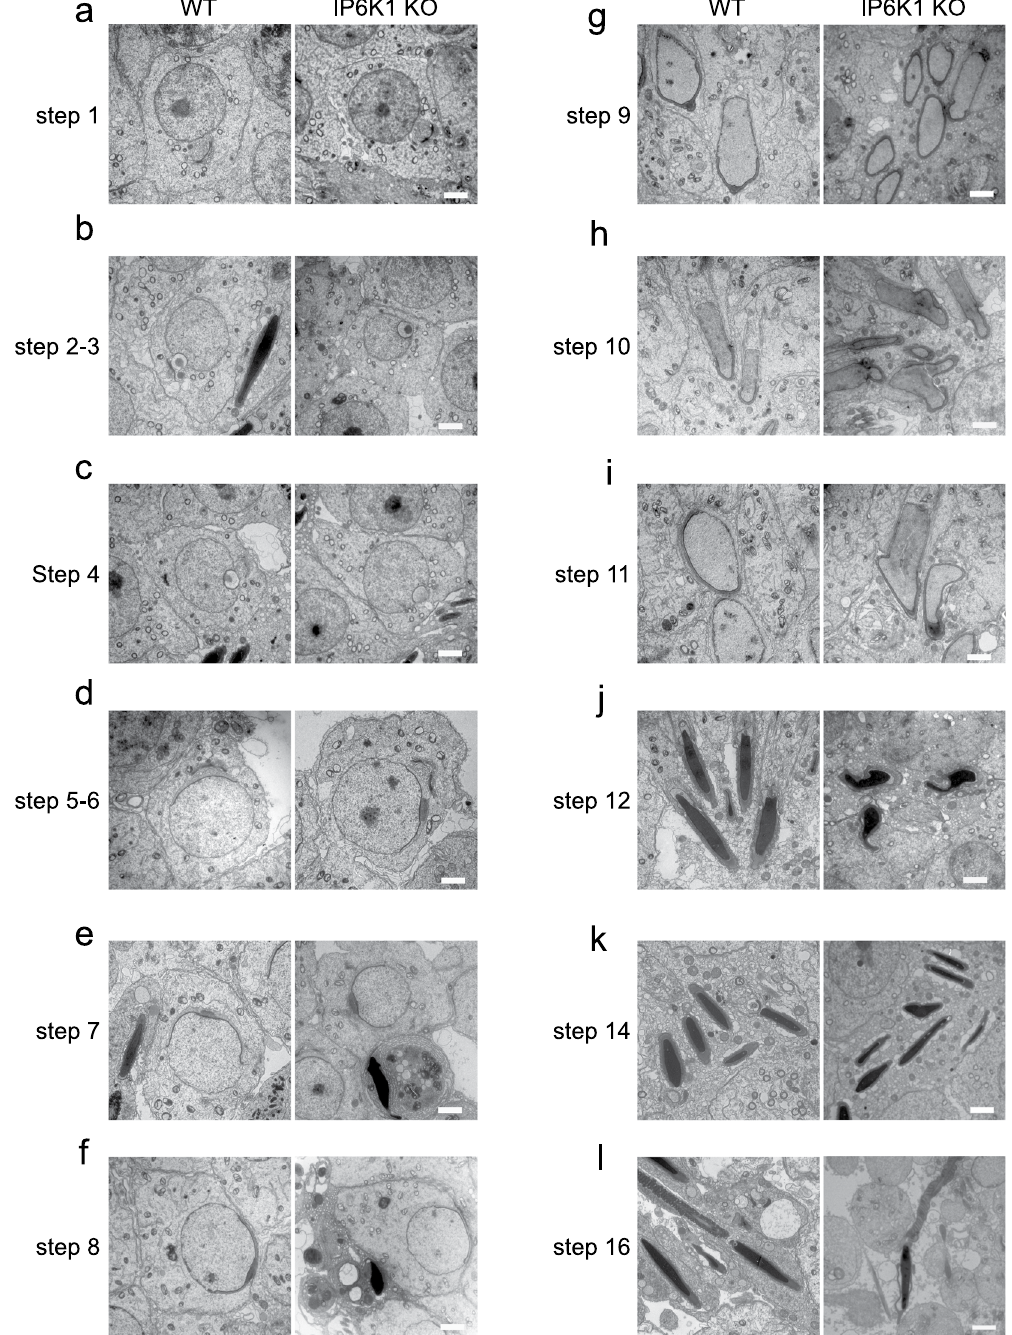
Figure 5. IP6K1 deletion caused disorientation and malformation of elongating/elongated spermatids. ( a–l) Electron microscopy showed steps 1–16 spermatids from wild type and IP6K1 KO mice. ( a , b , c , d , e , f ) Steps 1 to 8 round spermatids of IP6K1 KOs displayed relatively normal morphology. ( g , h , i , j , k , l ) Steps 9 to 16 elongating/ elongated spermatids in IP6K1 KOs were disoriented and malformed Scale bar 2 μ